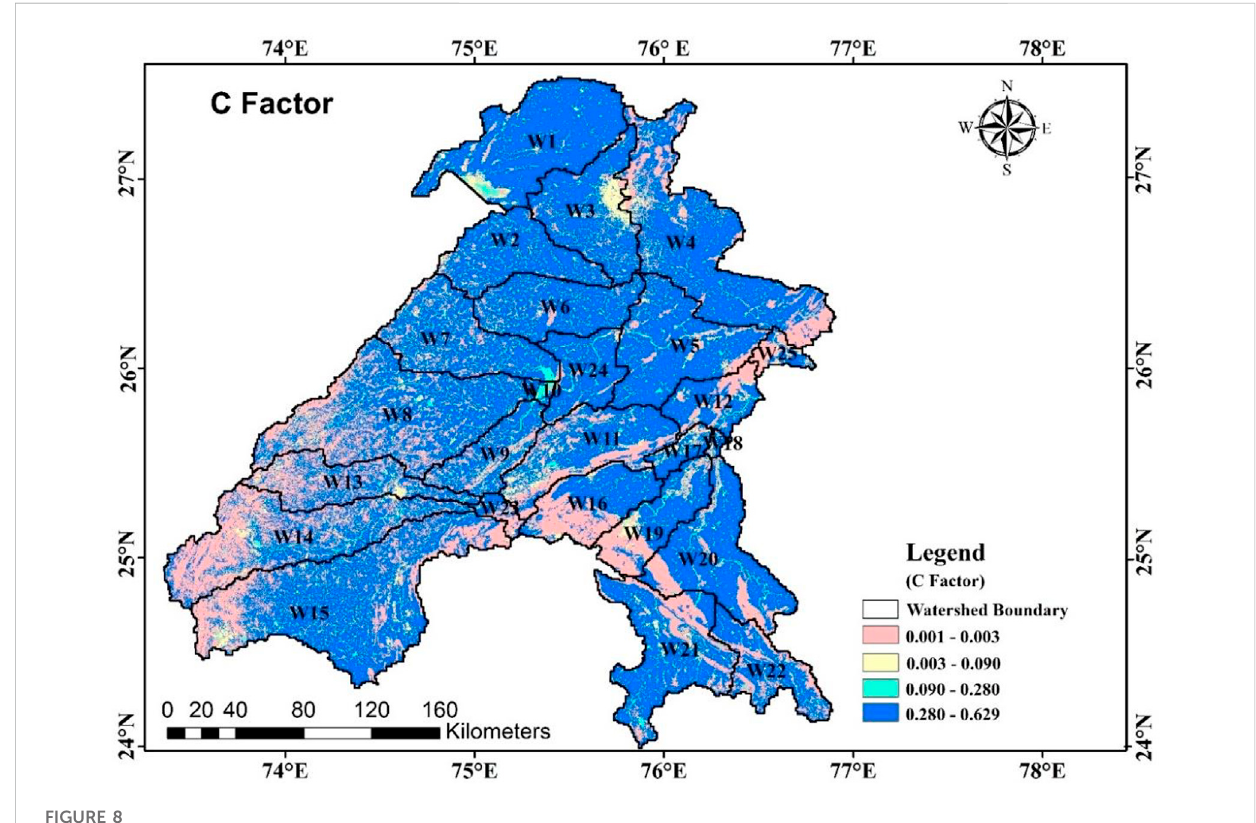
C factor map of the study